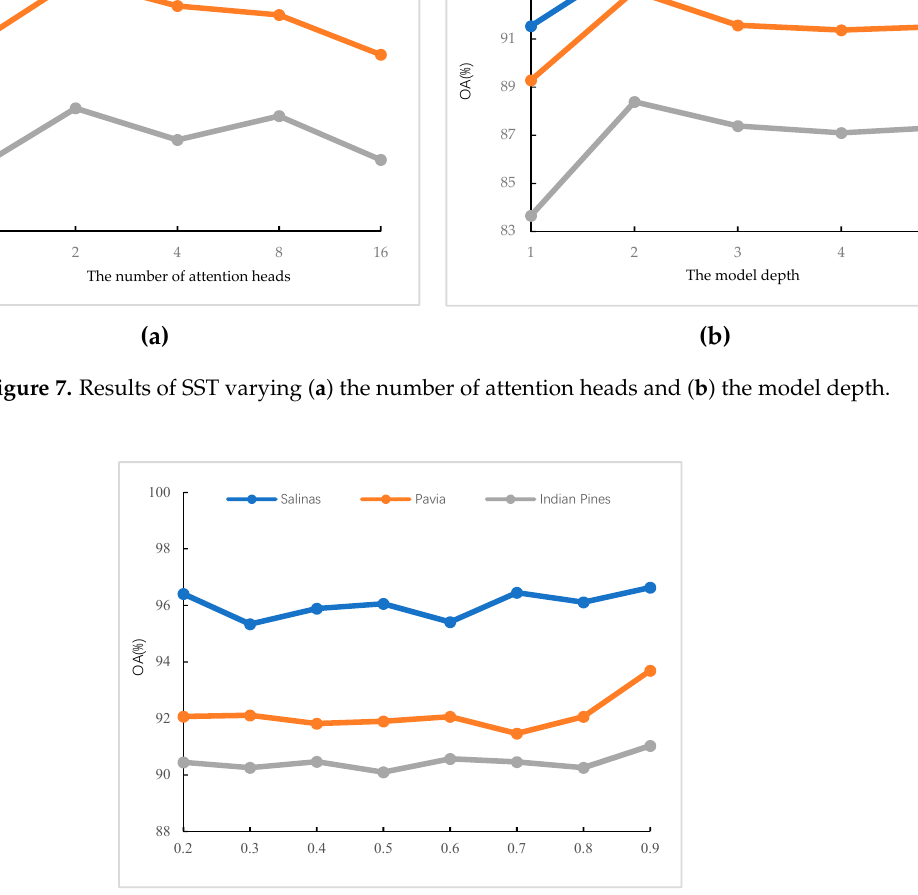
Figure 8. Analysis of the performing results of the parameters 𝜺 .